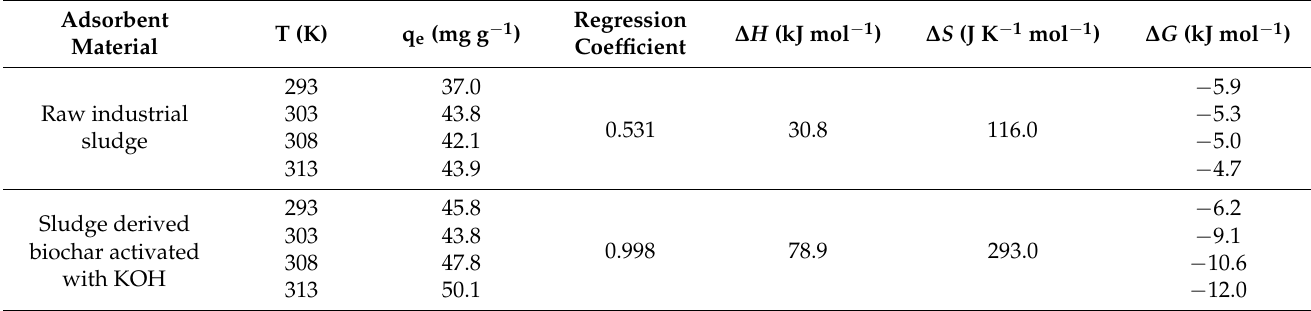
Table 5. Thermodynamic parameters of MB adsorption onto IS-R and